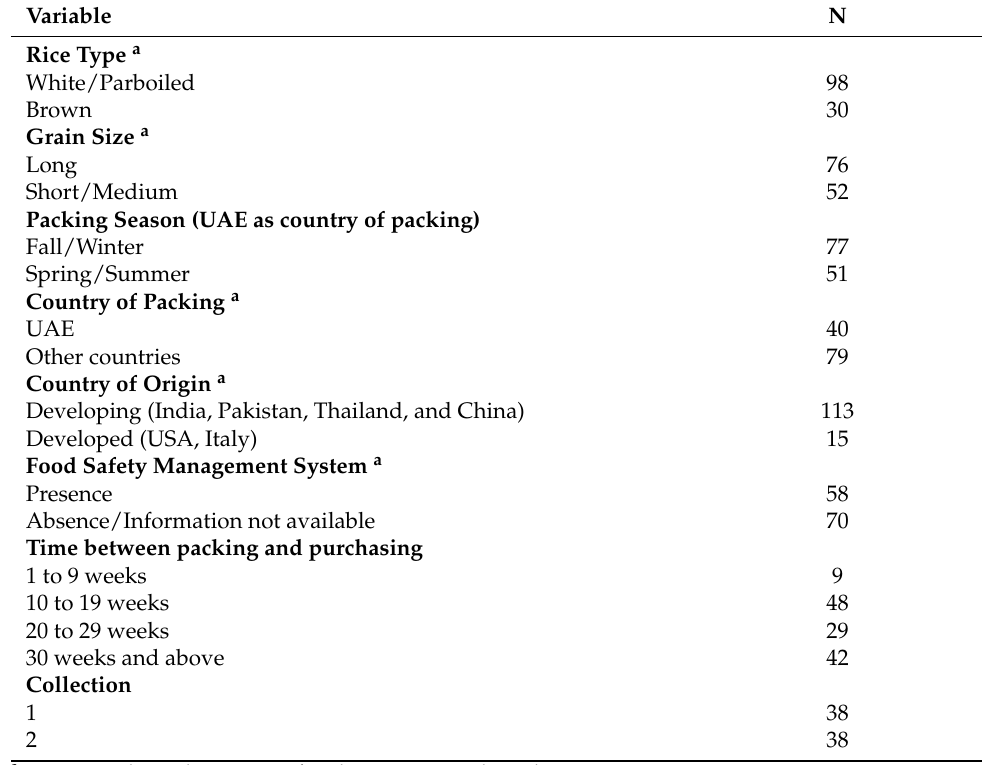
Table 1. Characteristics of the rice